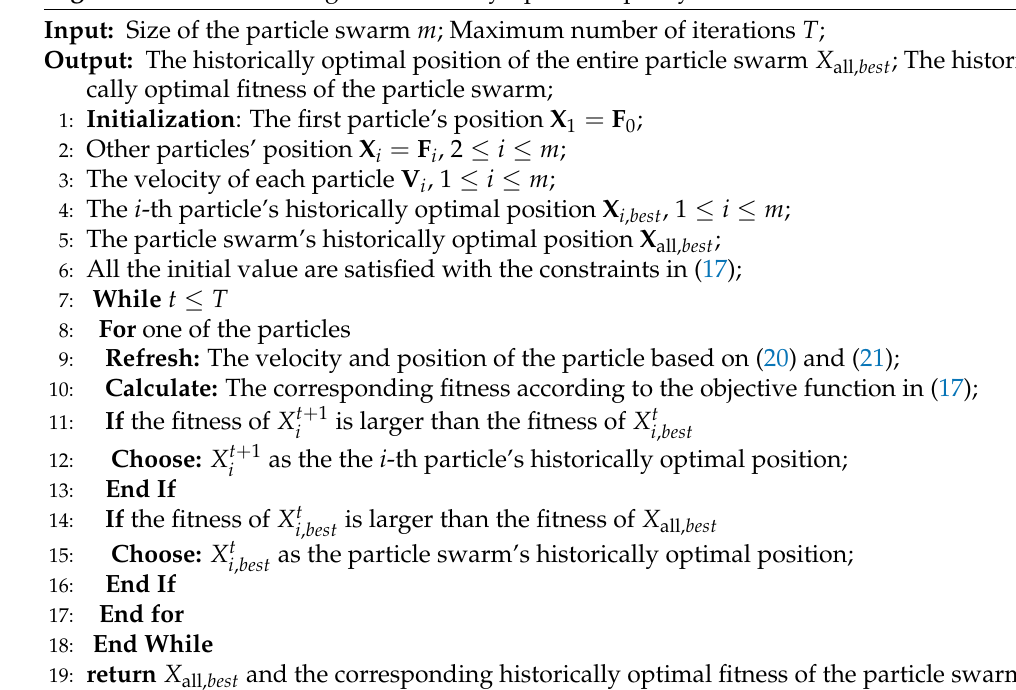
Algorithm 1 The RPSO algorithm for Asymptotic Capacity